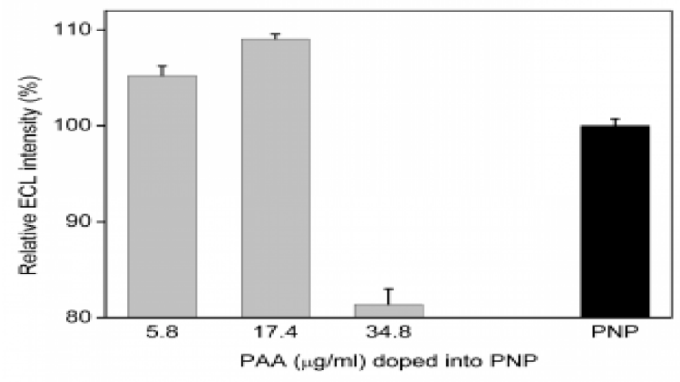
Figure 4. Effect of the doping amount of PAA on the ECL intensity of the polymer nanoparticle PNP.